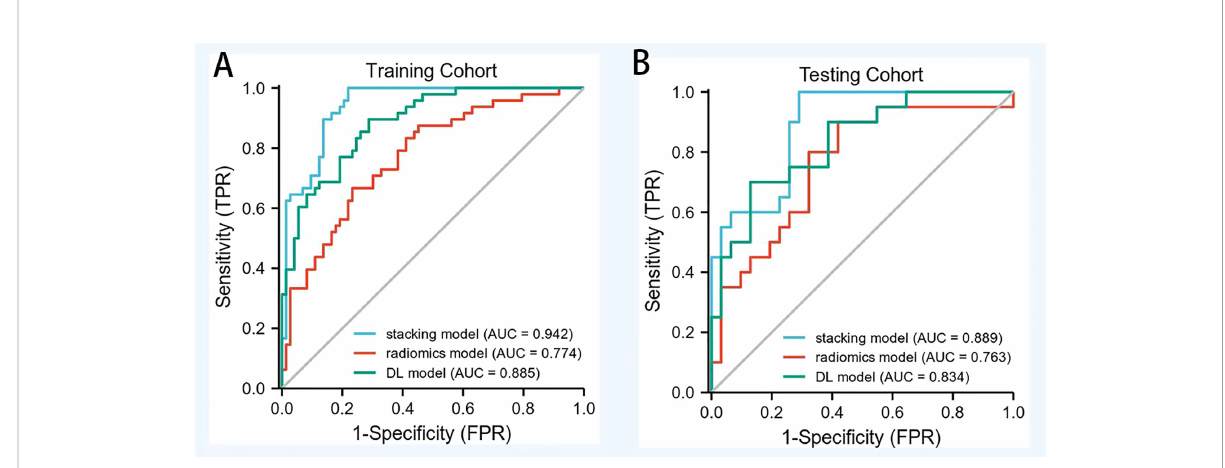
FIGURE 4 The ROC of radiomics model, DL model and combined model in training cohort and testing cohort. (A) AUC of combined models in training cohorts (AUC of 0.911) was signi fi cantly higher than that of the radiomics model (AUC of 0.740) and DL model (AUC of 0.887). (B) AUC of